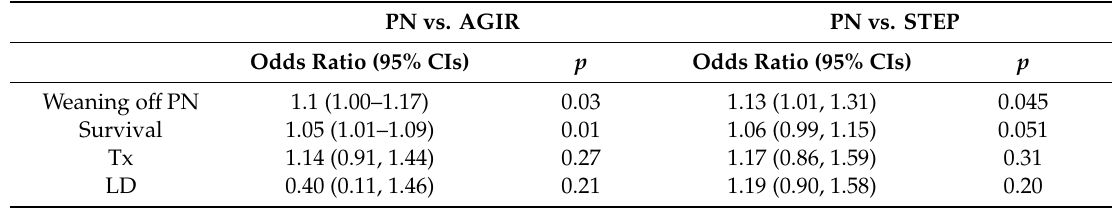
Table 6. Logistic binary PN vs. AGIR and PN vs.